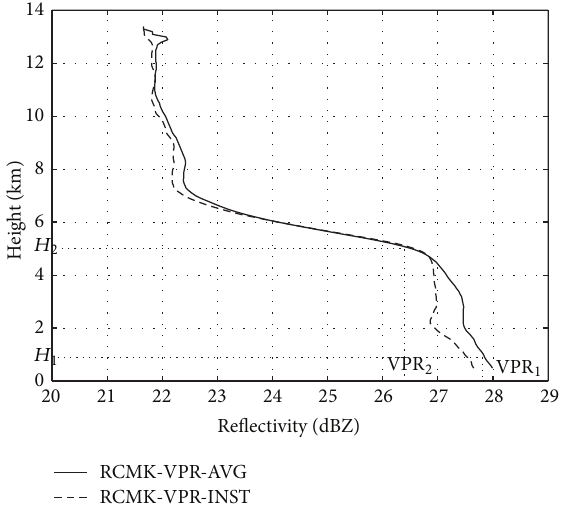
Figure 4: The vertical profile of reflectivity obtained on 0320 UTC 9 August 2009. The 1-hour averaged RCMK-VPR-AVG (0220 ∼ 0320 UTC) and instantaneous RCMK-VPR-INST are